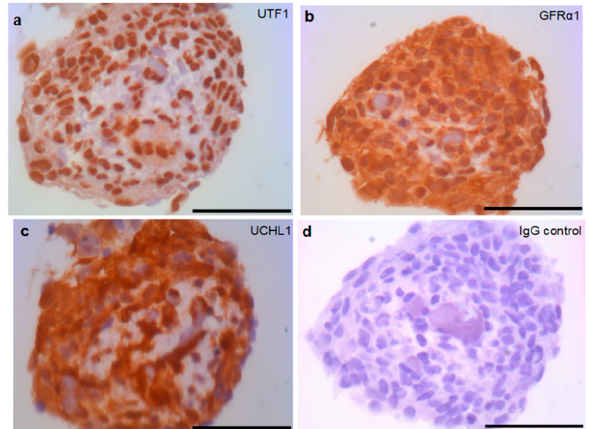
Figure 3. SSC-like cell clusters express SSC markers. Immunostaining of cross sections of SSC-like cell clusters by (a) undifferentiated embryonic cell transcription factor 1 (UTF1), (b) GDNF family receptor alpha-1 (GFR α -1), (c) ubiquitin carboxyl-terminal hydrolase isozyme L1 (UCHL1), and (d) IgG negative control. Scale bars: 50 µm.